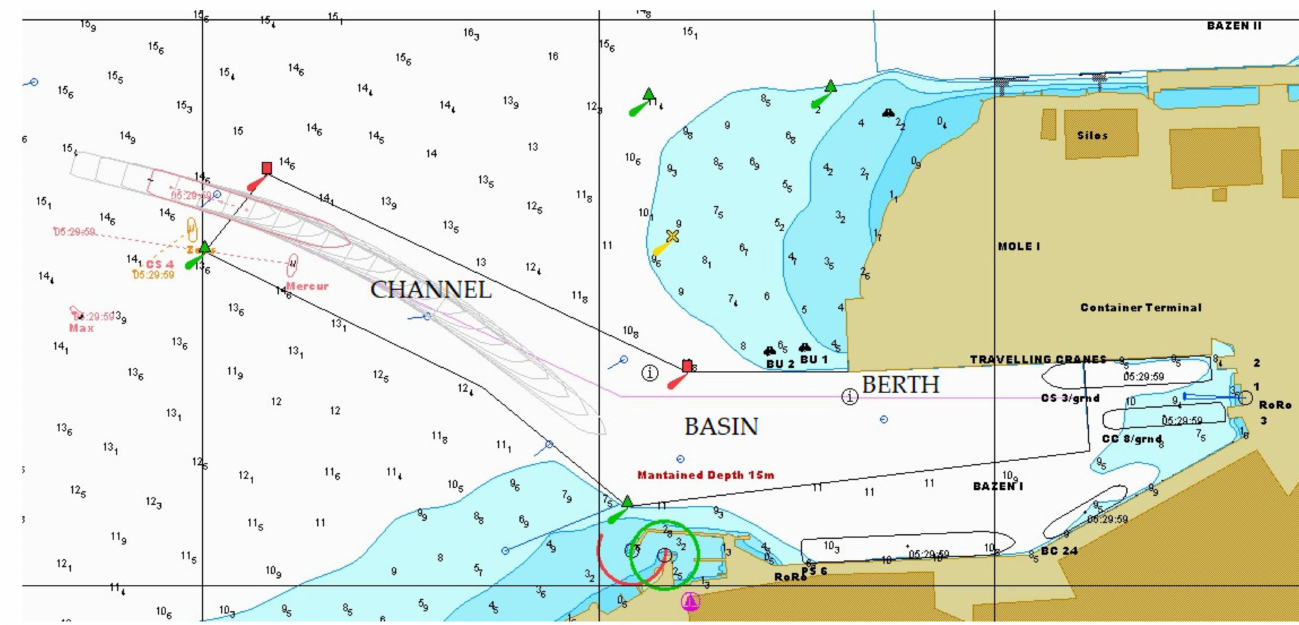
Figure 3. Port of Koper-approach to the container terminal. As seen on the electronic chart, the ship entered the canal at an undesirable angle due to strong wind. Two tugs assisted the 14 m draft container ship to stay on course within the dredged